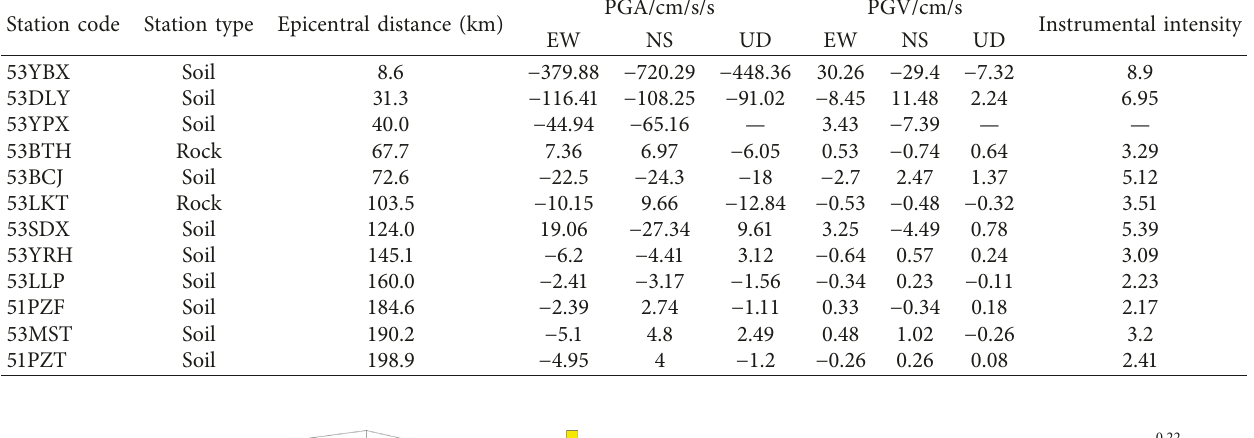
Table 1: Typical strong motion records and some related parameters of the Ms 6.4 earthquake at epicentral distances of less than 200km. Station code Station type Epicentral distance (km)